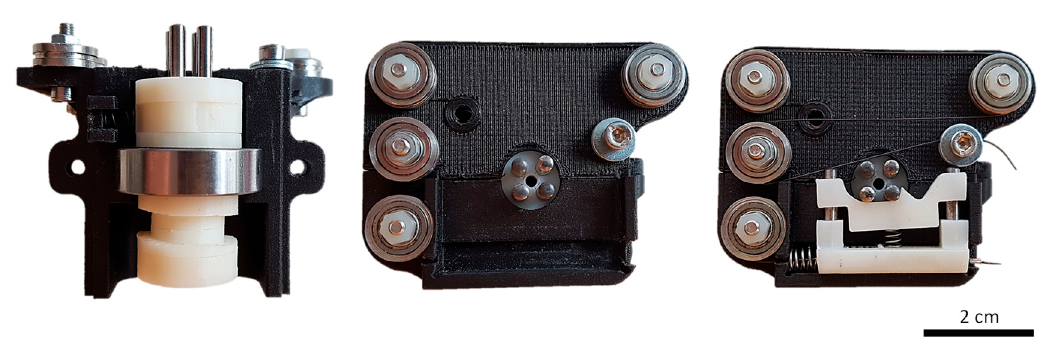
Figure 13. Assembly steps of the additive manufactured prototype.